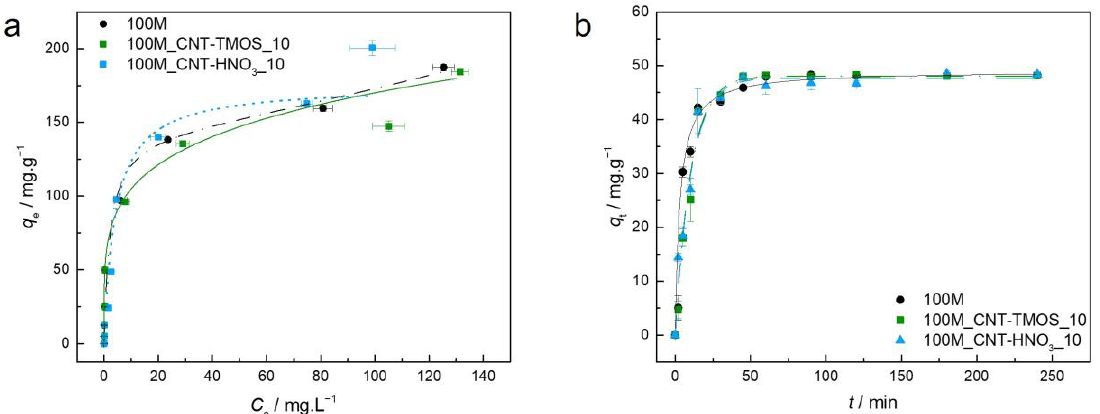
Figure 4. ( a ) — Experimental equilibrium data and the best fitted isotherm model for adsorption of xylene into the studied aerogels (dotted line — Langmuir; solid line — Freundlich; dashed line — BET). ( b ) — Representative plots of the fit of non-linearized form of pseudo-first order (dashed line) or pseudo-second order (solid line) equations to the data of experimental adsorption capacity as function of time, for the studied adsorbents towards xylene ( C 0 = 100 ppm, 15 rpm, 20 °C).